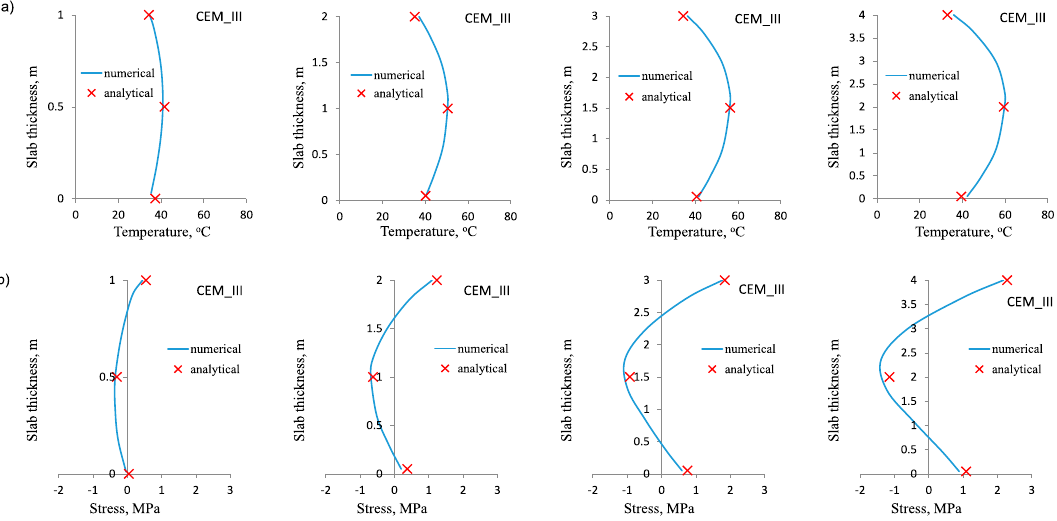
Figure 6. Numerical and analytical results for slabs made of concrete with cement CEM III: ( a ) Temperature distribution at the slab thickness, ( b ) total stress distribution at the slab thickness.